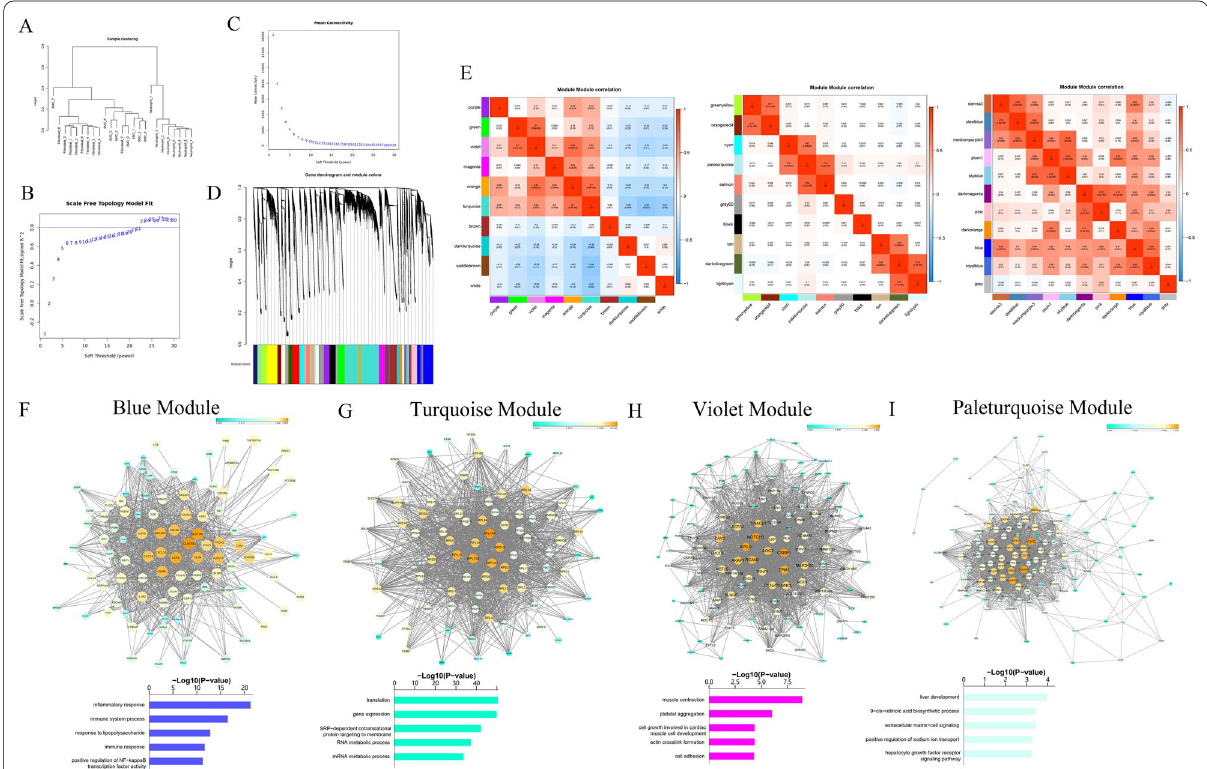
Fig. 8 Correlated modules identified by WGCNA among VSMCs, FBs and neutrophils. A Sample cluster of VSMCs, FBs and neutrophils. B – C identification of soft threshold for WGCNA. D – E the hierarchical cluster dendrogram and correlation analysis identified 12 co‑expression modules. F – I networks and gene functions for blue, turquoise, violet and paleturquoise